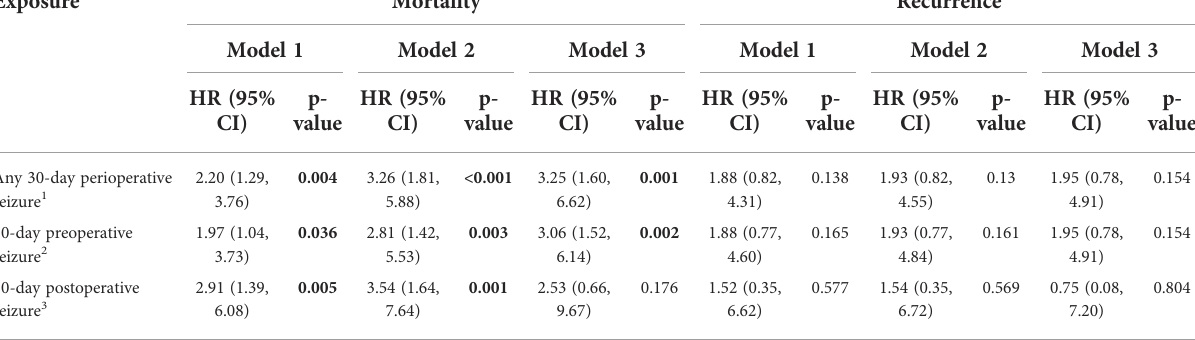
TABLE 2 Cox proportional hazards models showing the effect of 30-day perioperative seizures on overall mortality and recurrence of brain metastases. Exposure